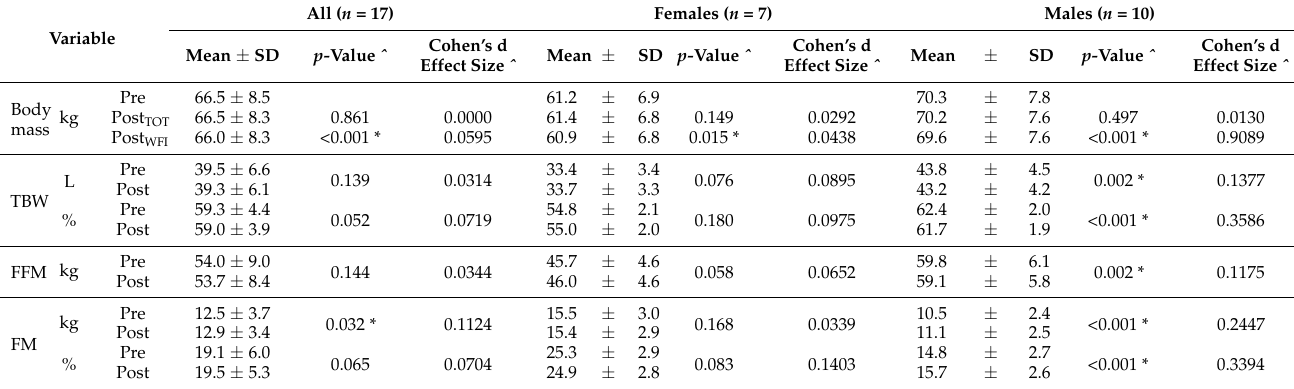
Table 2. Body mass and composition before (pre) and after (post) workout in the whole group, female and male.